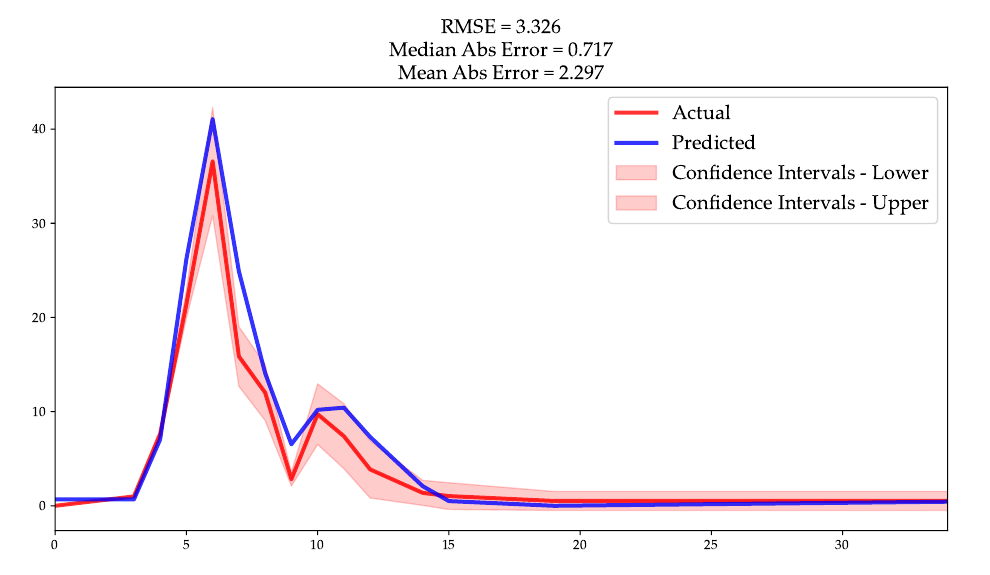
Figure 12. Conditional survival forest for cluster 4. Table 5. Feature importance in the survival model with cluster 4.